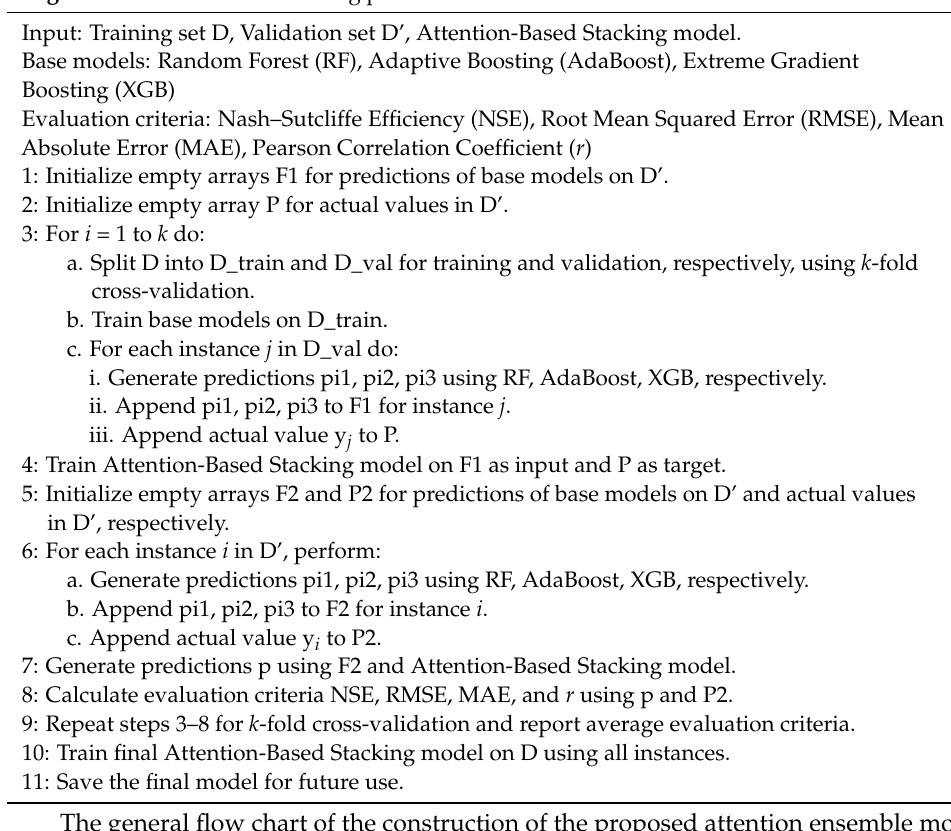
Algorithm 1 The iterative training process of the ATE model